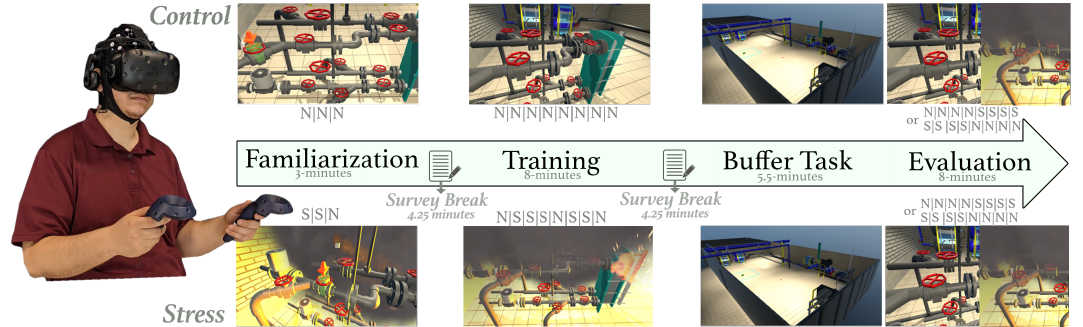
Figure 1. Study Protocol with the familiarization, training, buffer, and evaluation segments. ‘N’ refers to trials completed under normal environmental conditions, and ‘S’ refers to trials completed under stressful environmental conditions. A survey break was used to ask the participants several survey